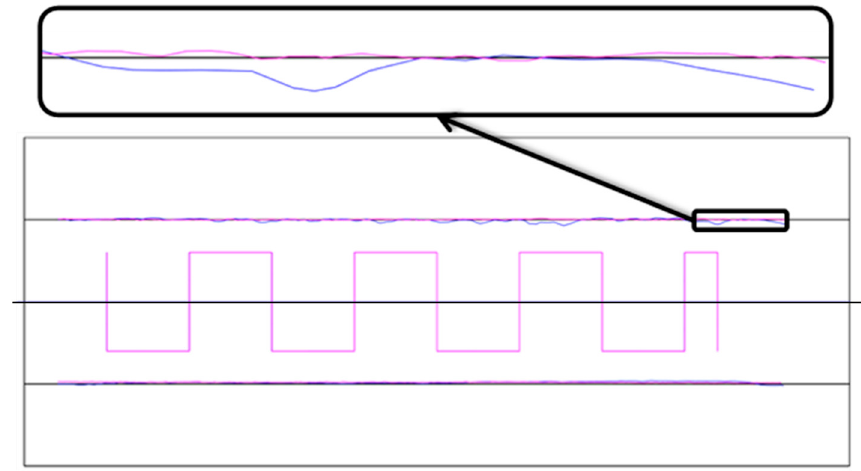
Figure 9. Top view measurements for Al and PUR 300.